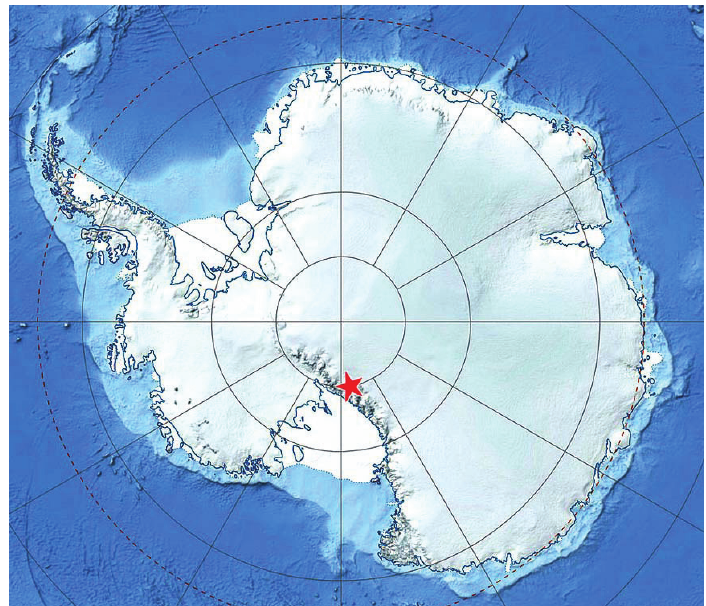
Figure 1. The type locality for Antarctotrechus balli sp. n. is shown by the red star. Image map is a modified MODIS Mosaic of Antarctica from National Snow and Ice Data Center, http://nsidc.org/data/moa/